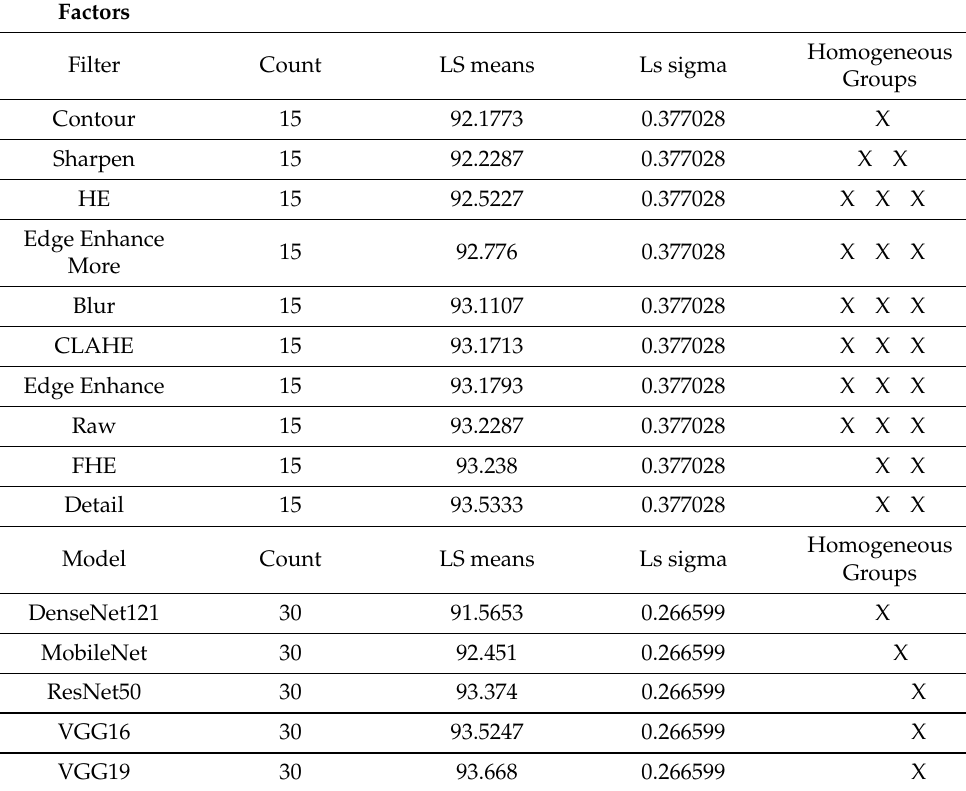
Table 7. Multiple Range Tests for the different factors. Method: 95.0 percent